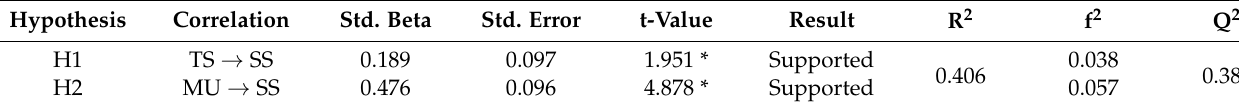
Table 2. Path Coefficient Test Results.